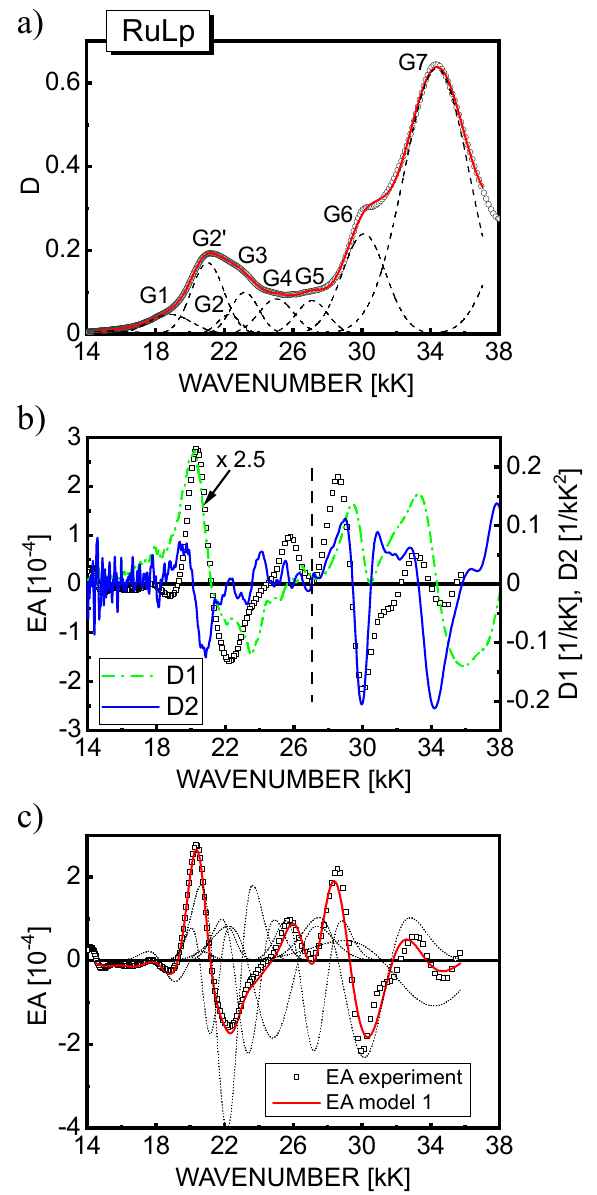
Figure 5. ( a ) The absorption spectrum of a 42 nm − thick RuLp(PF 6 ) 2 (squares) and its Gaussian profile analysis. The solid line obtained by the superposition of the Gaussian profiles (dashed lines); ( b ) The EA spectrum of RuLp(PF 6 ) 2 film (squares) measured at the electric field strength, F rms = 6 · 10 5 V/cm, compared with the calculated first (D1, dash − dotted line) and second (D2, solid line) derivatives of the absorption spectrum shown in part (a) of the figure. The values of all signals were multiplied by a factor of 2.5 in the lower − energy range indicated by the dashed vertical line; ( c ) The best fit of experimental EA data for RuLp(PF 6 ) 2 (squares) with the theoretical curve calculated according to model 1 (solid line). The dotted lines represent the second derivative contributions from the corresponding Gaussian